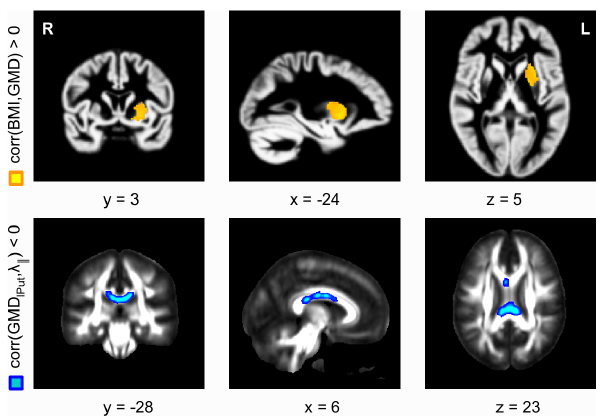
Figure 2. Correlation between GMD lPut and l ||; . A positive correlation was observed between BMI and GMD in the left putamen ( A ; color-coded in yellow, p , 0.05, FWE-corrected). l ||; was negatively correlated with GMD lPut , predominantly in posterior and inferior areas of the body of corpus callosum ( B ; color-coded in blue, p , 0.05, TFCE-corrected). Correlations between GMD lPut and the other diffusion parameters, FA, l H , and ADC, did not reach